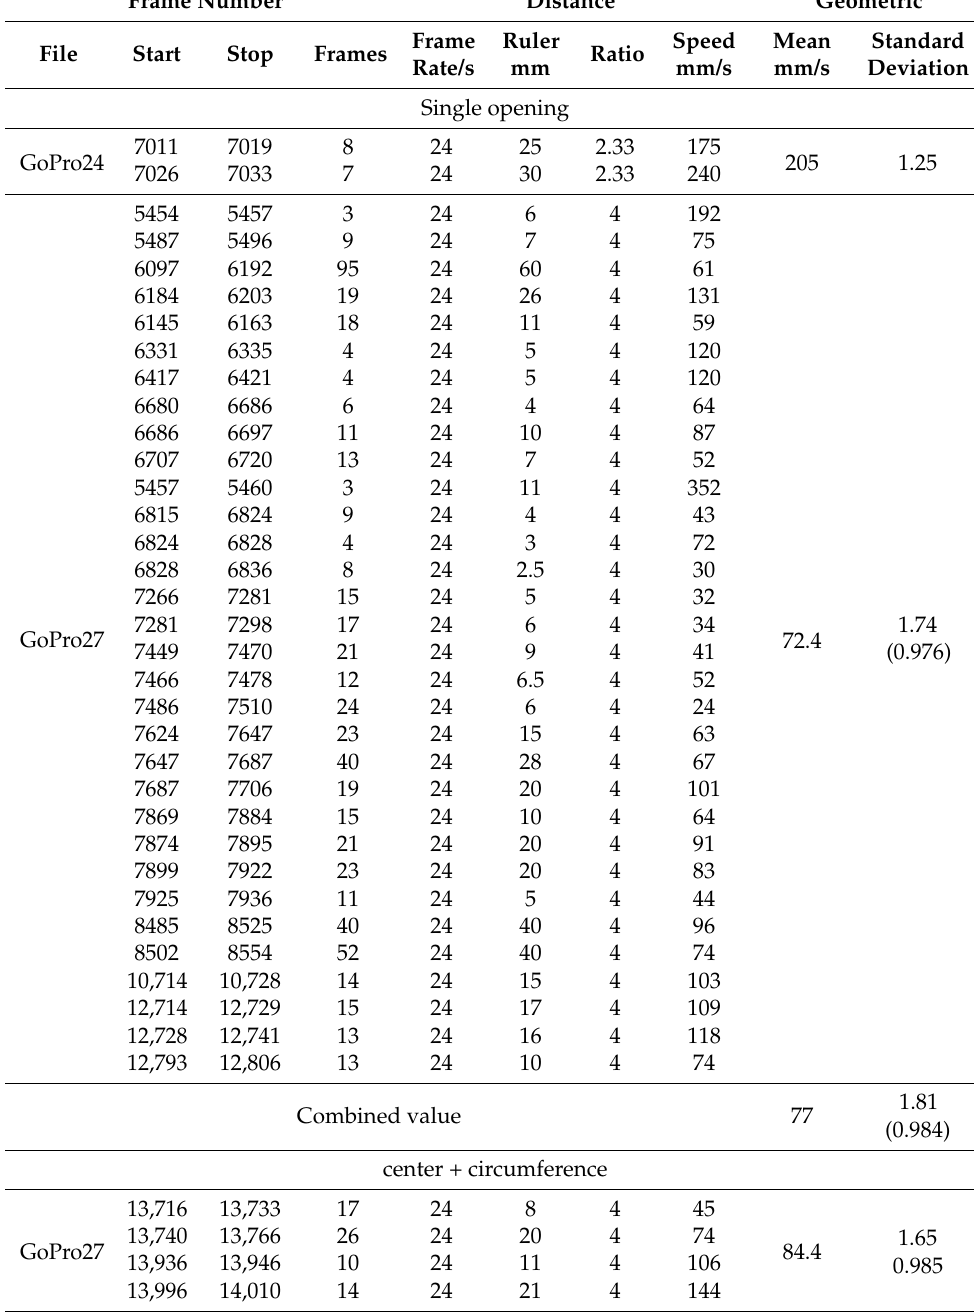
Table 4. Horizontal air motion along the underside of the manhole cover and the upper